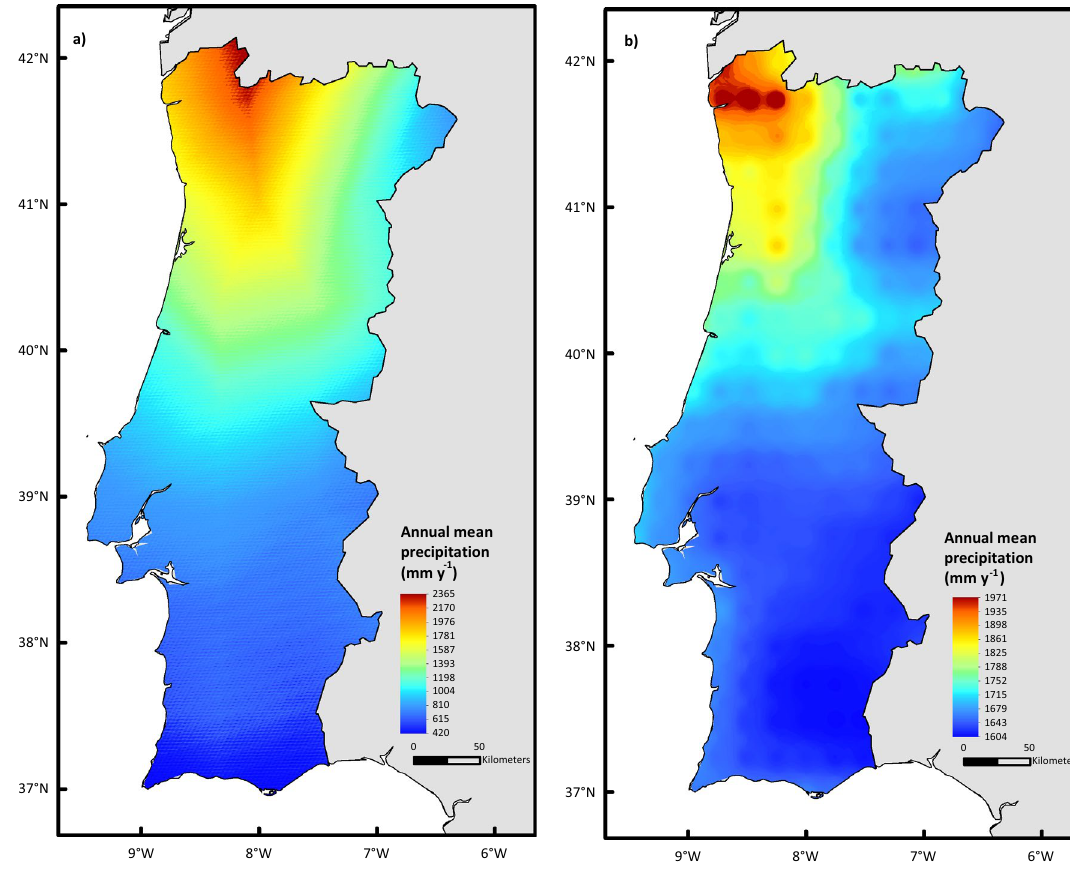
Figure 3. Mean annual precipitation for the 1980–2018 hydrological periods according to the ERA-Interim ( a ) and ERA5 ( b ) datasets. Datasets details available in Table 1.